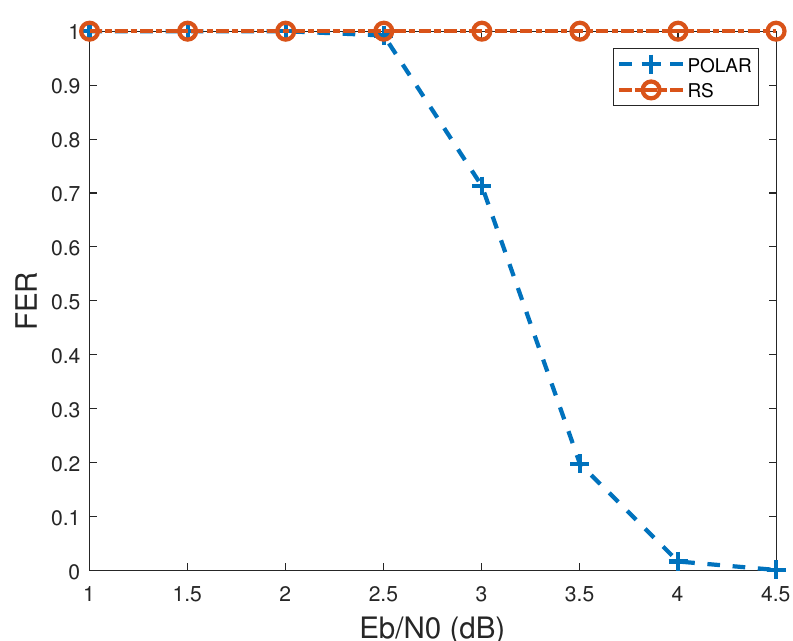
Figure 7. FER of different SNR values for RS and Polar codes.